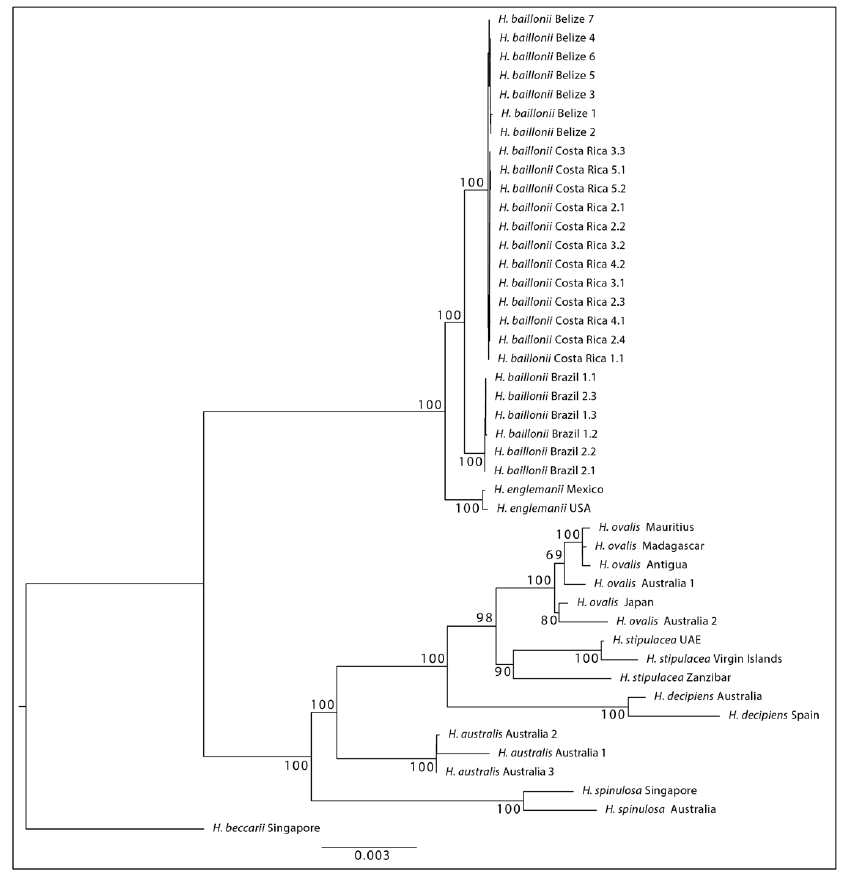
Figure 2. Maximum-likelihood topology obtained from chloroplast hybridization capture of 24 chloroplast regions for 45 samples of Halophila using PhyML, Halophila beccarii was used to root the tree. the